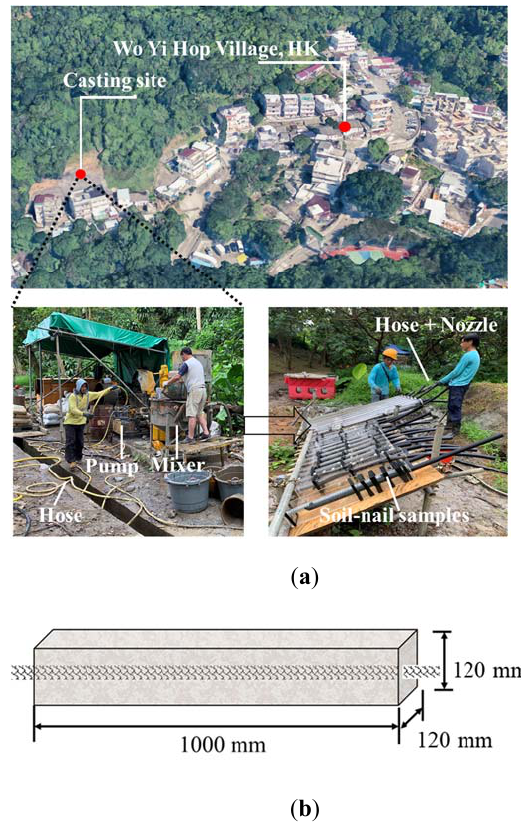
Figure 1. The onsite casting of CP and ECC grouts ( a ) and the dimension of samples ( b ).